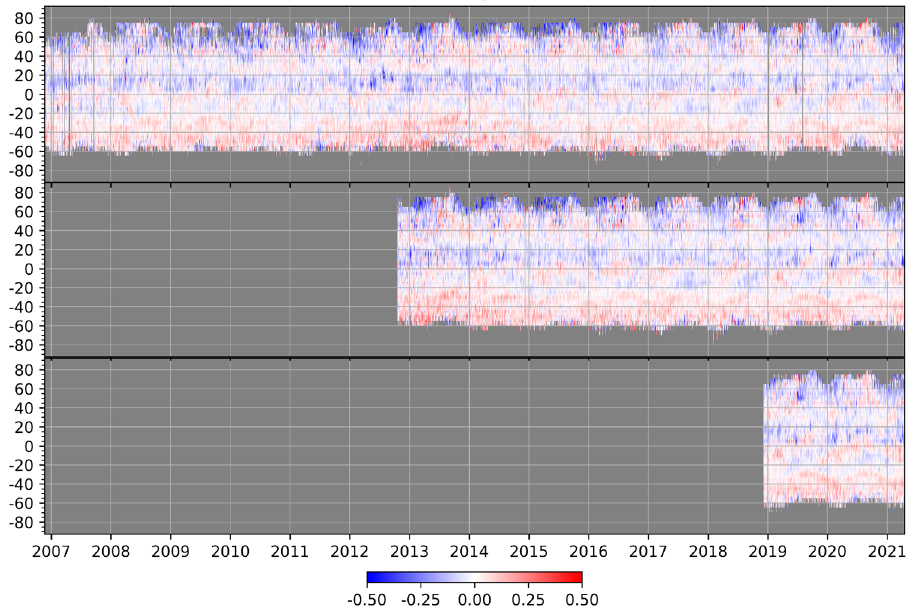
Figure 22. Same as in Figure 19 but for daytime PWR – (D+TM) SST.